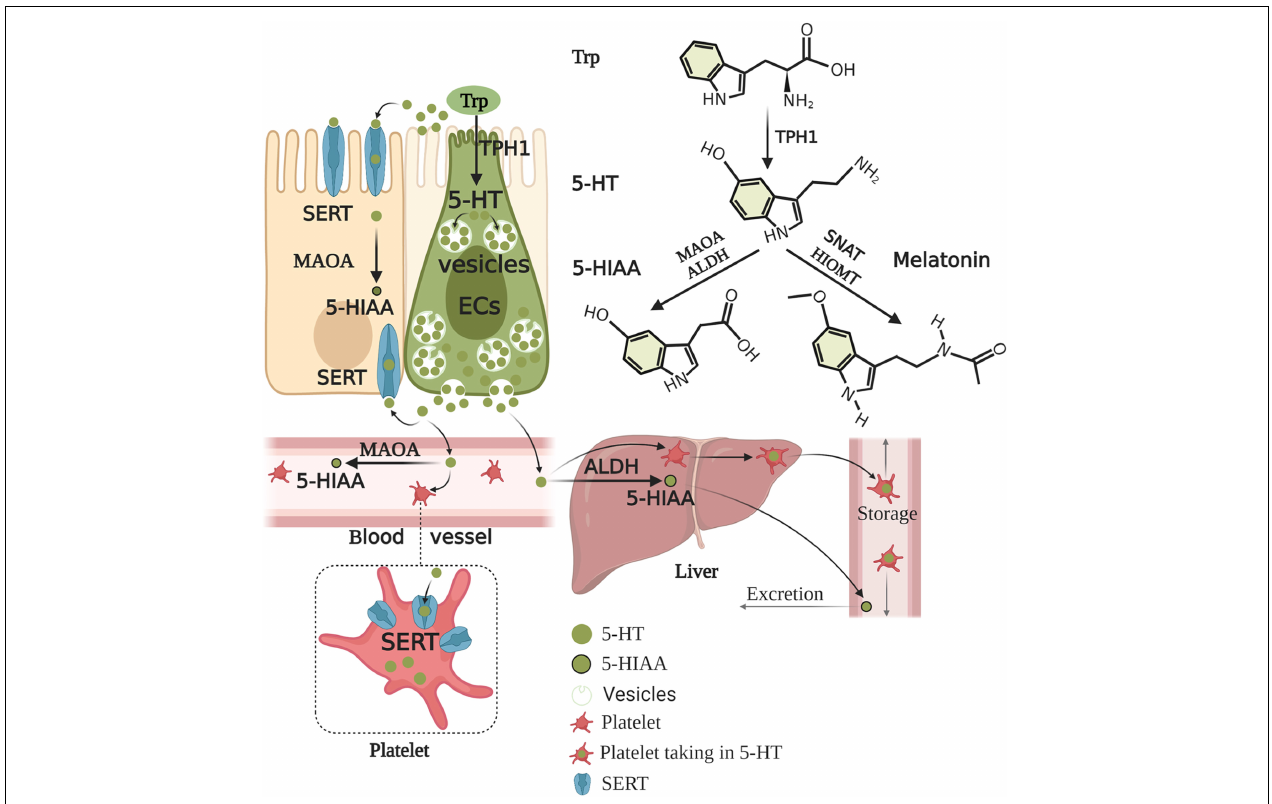
FIGURE 2 | Enterochromaffin cells synthesis of serotonin and its metabolism and excretion. Trp is converted to 5-HTP by TPH1 of ECs. 5-HTP is then metabolized to 5-HT by AADC. Upon production, 5-HT is stored in large dense core vesicles of ECs and prepared for release when required by the body. 5-HT acts on objective cells to exert nutrition, intestinal motility, secretion, and proinflammatory and anti-inflammatory effects. 5-HT is released into the lumen and lamina propria and can enter the blood in the lamina propria. 5-HT must be rapidly removed to prevent excessive activation and/or receptor desensitization. 5-HT is taken up by almost all epithelial cells, nerves, immune cells, and platelets via SERT. 5-HT is inactive and converted to 5-HIAA by enterocytes and enteric neurons with MAOA. The portal circulation is first processed by the liver before the blood enters the systemic circulation. Free 5-HT in the blood is rapidly degraded by MAOA or ALDH in the liver, while 5-HT in platelets is protected from degradation. Thus, generally, only 5-HT stored in platelets enters the general circulation. 5-HIAA in the general circulation is finally excreted through the urine. Conversely, 5-HT can also be further metabolized to melatonin by SNAT and HIOMT. Trp, tryptophan; 5-HTP, 5-hydroxy- L -tryptophan; TPH1, tryptophan hydroxylase 1; AADC, aromatic amino acid decarboxylase; 5-HT, serotonin; SERT, serotonin reuptake transporter; MAOA, monoamine oxidase A; 5-HIAA, 5-hydroxyindole acetic acid; ALDH, aldehyde dehydrogenase; SNAT, serotonin N-acetyltransferase; HIOMT, hydroxyindole